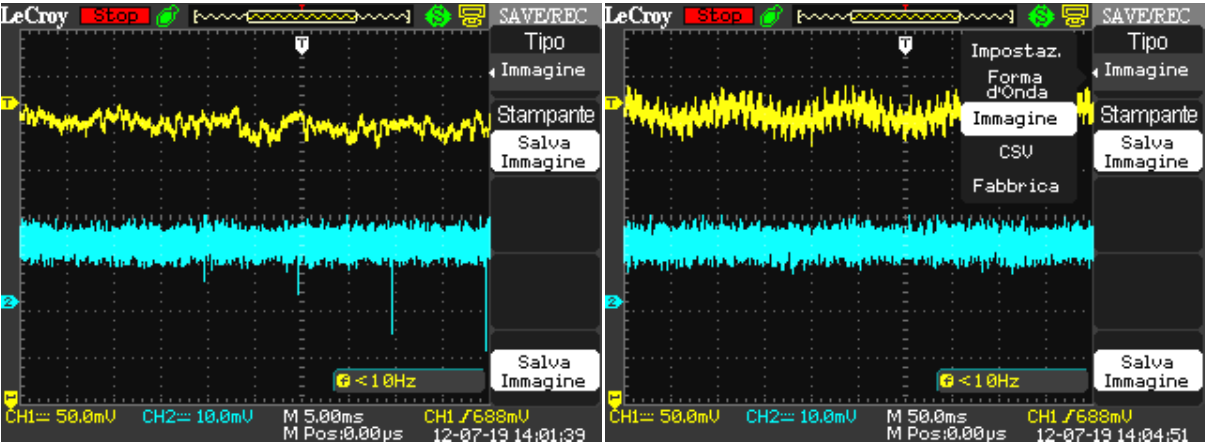
Figure 19. ( a ) DC to ground voltage (cyan trace) and DC current (yellow trace); ( b ) Particular of the DC current oscillation due to